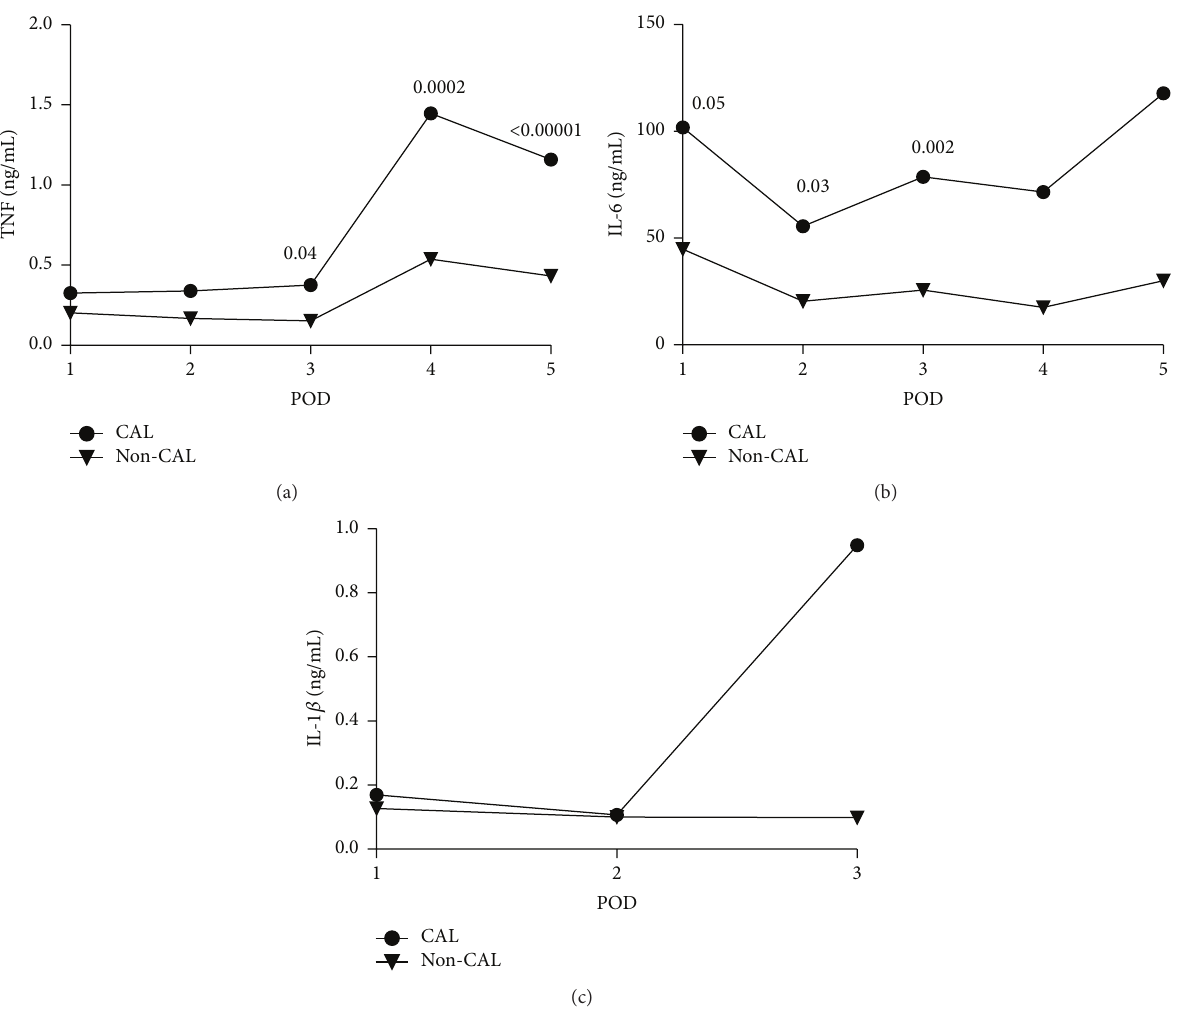
Figure 2: Weighted means of peritoneal levels of TNF (a, ng/mL), IL-6 (b, ng/mL), and IL-1 𝛽 (c, ng/mL) on each postoperative day (POD) comparing colorectal anastomotic leakage (CAL) patients with non-CAL patients; TNF (a), IL-6 (b), and IL-1 𝛽 (c). The 𝑃 values of differences are illustrated when